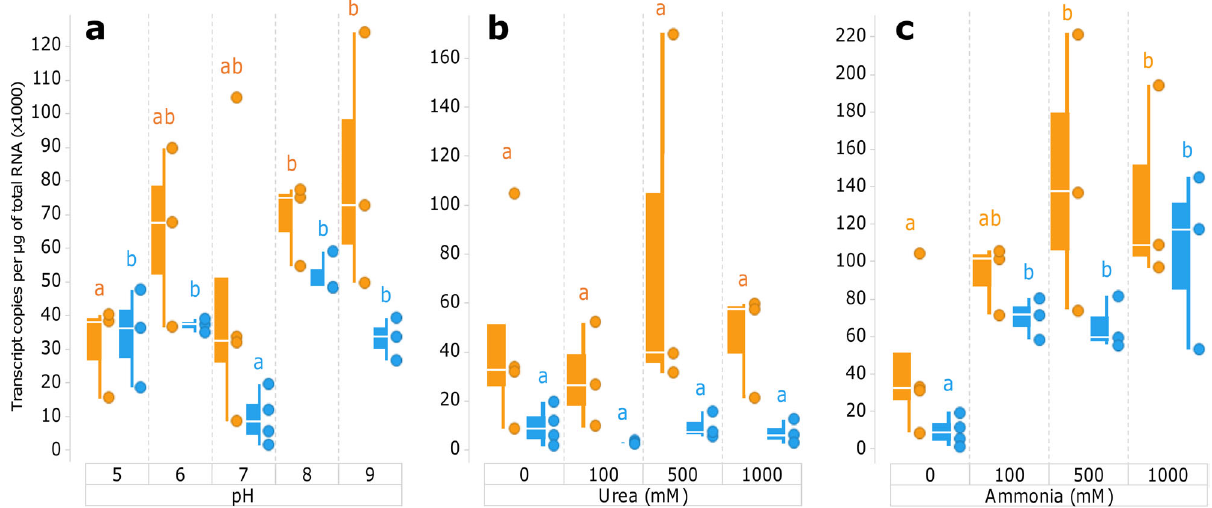
Fig. 4 Expression of the adc gene quanti fi ed by RT-qPCR in fl oating colonies and bio fi lms as a function of pH, urea and ammonia. For each bacterial lifestyle, conditions within each environmental insult were statistically compared pairwise as illustrated by letters above the corresponding distributions (blue for FFC and orange for SAB). Only letters of the same colours (referring to the same phenotype) can be compared. For each colour, when all letters are different between two distribuitions, then the expression levels in the two corresponding conditions are considered signi fi cantly different (Post-Hoc Tukey HSD; p < 0.05). If two distributions share at least one letter, then the expression levels in these conditions are not signi fi cantly different with a p ≥ 0.05. a Exposure of P. stuartii to different pHs. b Exposure to increasing concentrations of urea. c Exposure to